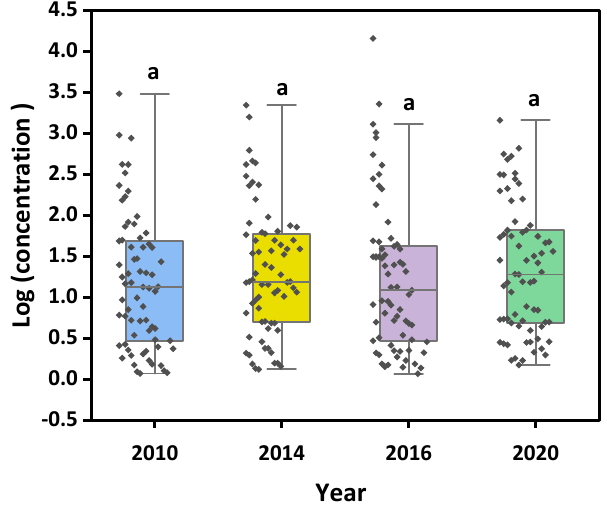
Figure 5. Annual variation of inorganic elements concentration between 2010 and 2020 in sewage sludge. The same letter indicates no statistical difference (Kruskal–Wallis test; Dunn’s test, p > 0.05).